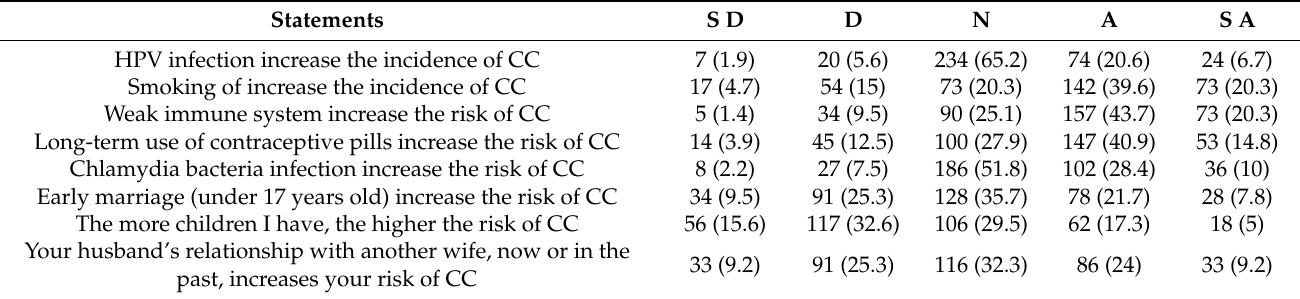
Table 4. Knowledge of risk factors for cervical cancer among